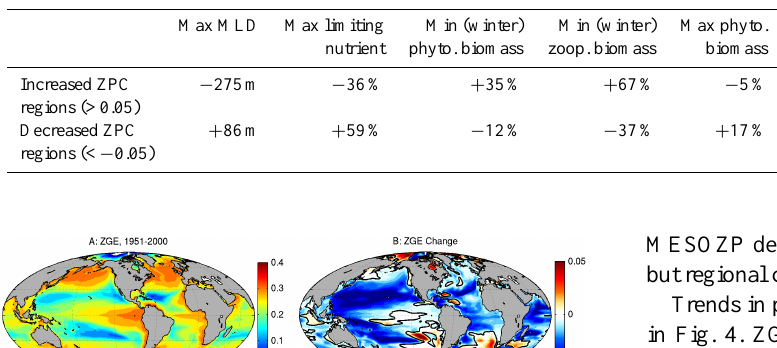
Table 1. Changes in physical and planktonic food web properties associated with regions where ZPC increases/decreases by more than 0.05. The limiting nutrient is defined as that imposing the greatest limitation in the annual mean averaged over small and large phytoplankton types.